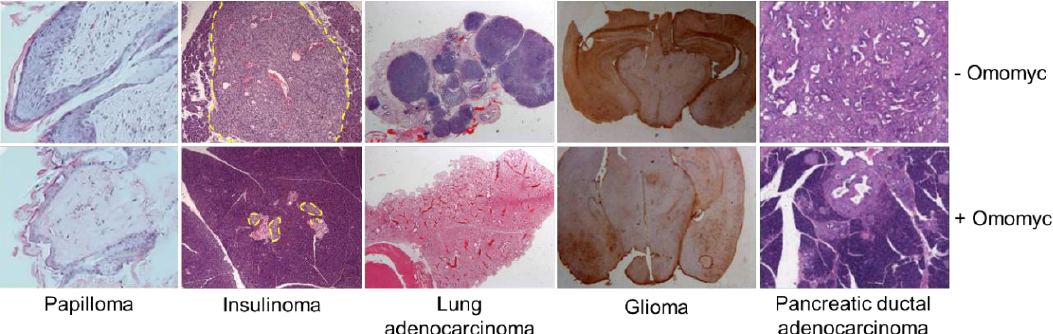
Figure 2. Expression of the Omomyc transgene has remarkable therapeutic impact in 5 different genetically engineered mouse models of cancer, from left to right: papilloma, inv-Myc-ER TAM (top panel) and inv-Myc-ER TAM / Omomyc (bottom panel), adapted from [56]; insulinoma, RIP1-Tag2 ; TRE-Omomyc;CMV-rtTA -dox (top) and + dox (bottom), adapted from [70]; lung adenocarcinoma, LSL-Kras G12D ; p53ER TAM ;TRE-Omomyc;CMV-rtTA -dox (top) and +dox (bottom), adapted from [71]; glioma, GFAP- V12 Ha-Ras;TRE-Omomyc;CMV-rtTA -dox (top) and +dox (bottom) adapted from [67]; and pancreatic ductal adenocarcinoma, pdx1-Cre;LSL-KRas G12D ;p53ER TAM ;TRE-Omomyc;CMV-rtTA -dox (top) and + dox (bottom), adapted from [72]. All panels represent tissue sections stained with either an anti-GFAP antibody (glioma) or with hematoxylin and eosin (rest of the panels). Pancreatic islets in the insulinoma panels are circled with a dotted yellow line.